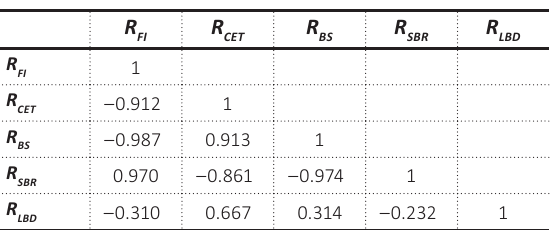
Table 7. Correlation matrix of indicators of decentralization of intergovernmental relations Source: Authors’ calculations.